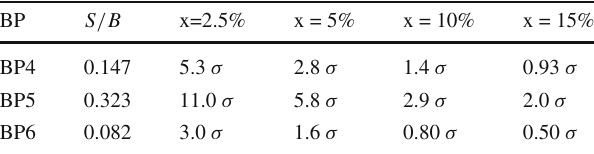
Table 13 The S / B ratio and signal significance for the benchmark points at 13 TeV with L = 3000 fb − 1 , in the b ¯ b + / E T final state, using ANN with 2.5%, 5%, 10% and 15% systematic uncertainty